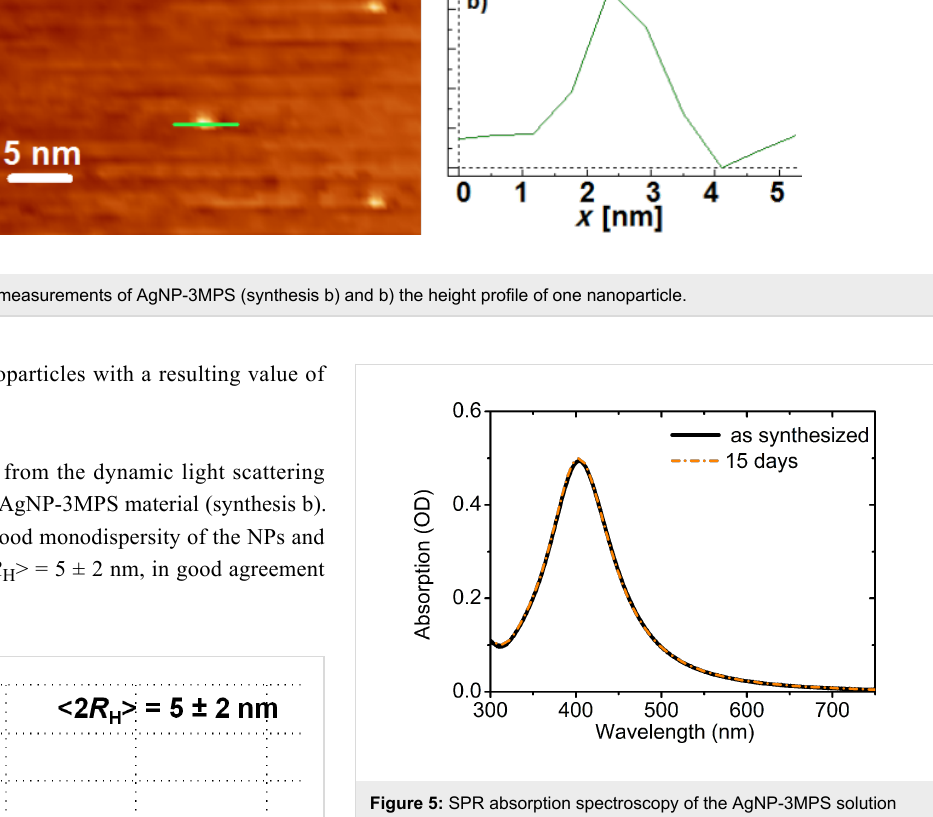
The SPR absorption was monitored as a function of the time in